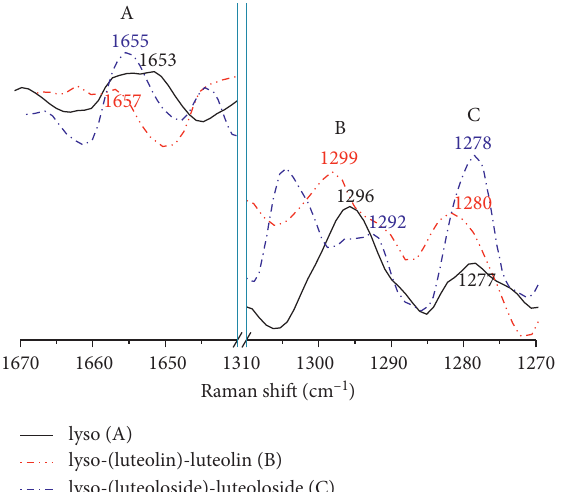
� 1 × 10 − 2 mmol/L, (LYSO)